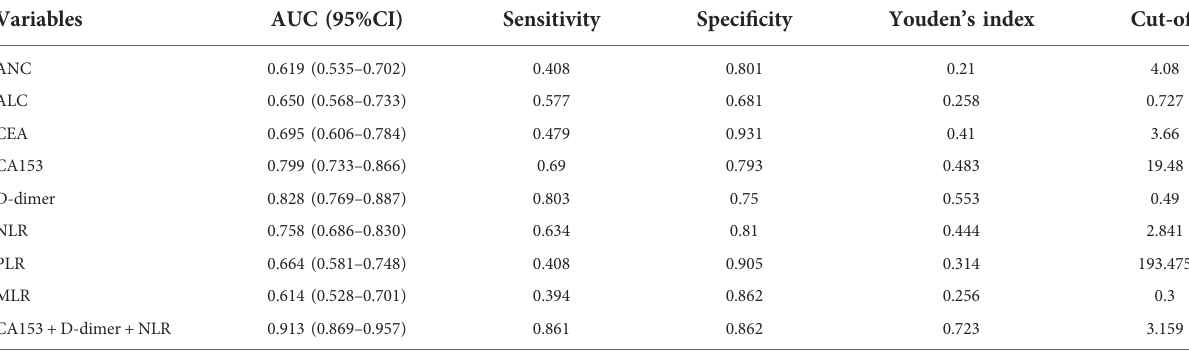
TABLE 4 Diagnostic values of hematological indicators for recurrence and metastasis of breast cancer.